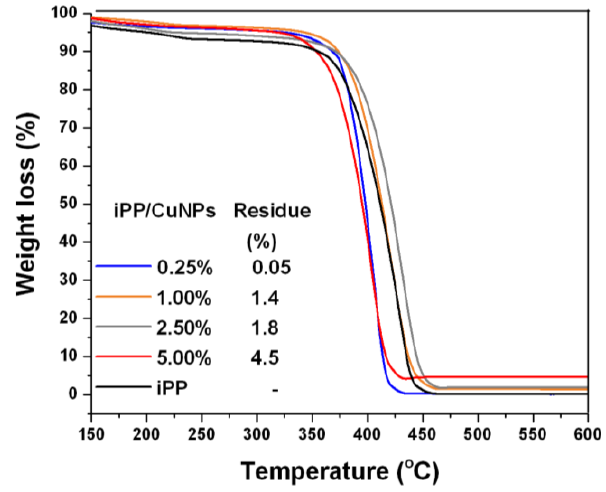
Figure 3. TGA thermographs of iPP and iPP/CuNPs composites.